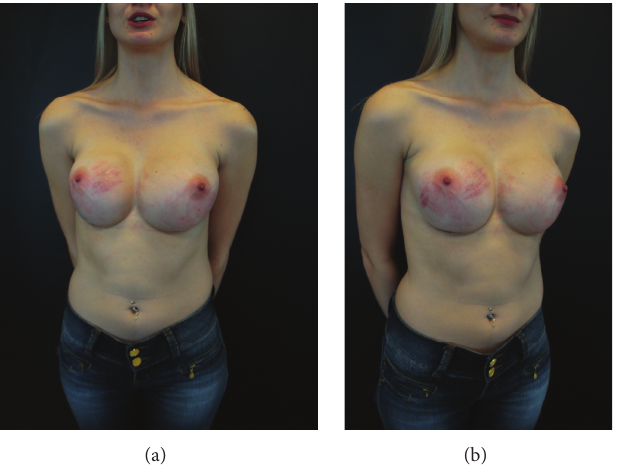
Figure 2: SD 6 weeks after 425 mL breast implants placement in a 24-year-old woman. (a) Frontal view, (b) oblique